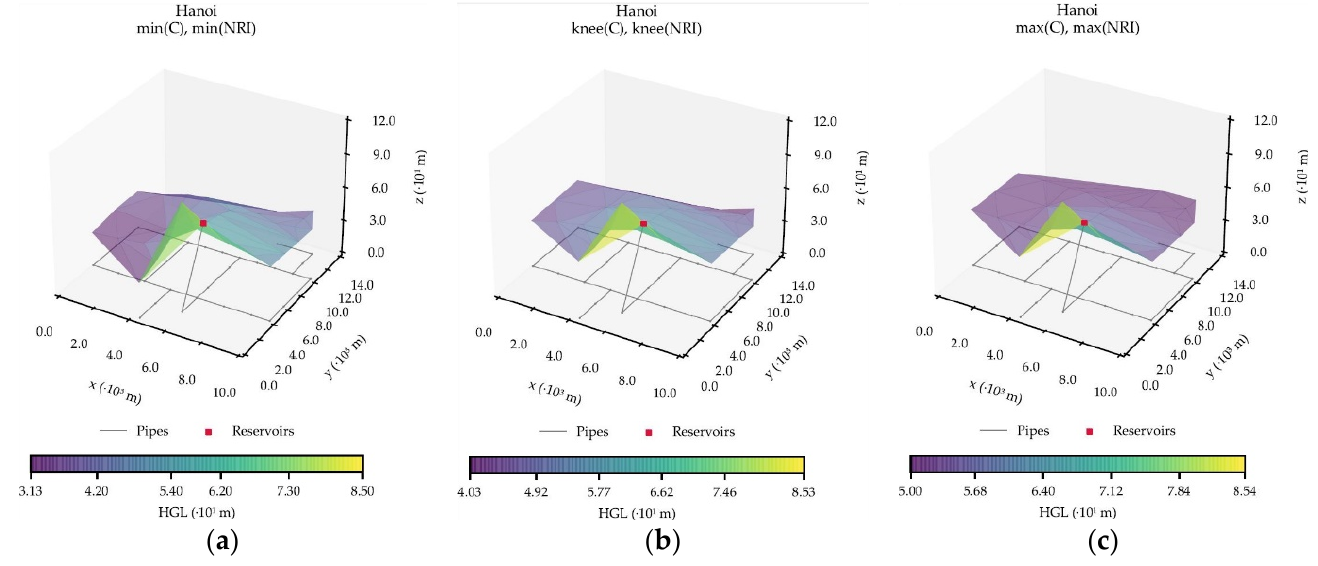
Figure 3. Hanoi WDS with the corresponding HGL surfaces for the: ( a ) [min( C ), min( NRI )]; ( b ) [knee( C ), knee( NRI )]; and ( c ) [max( C ), max( NRI )] configurations.